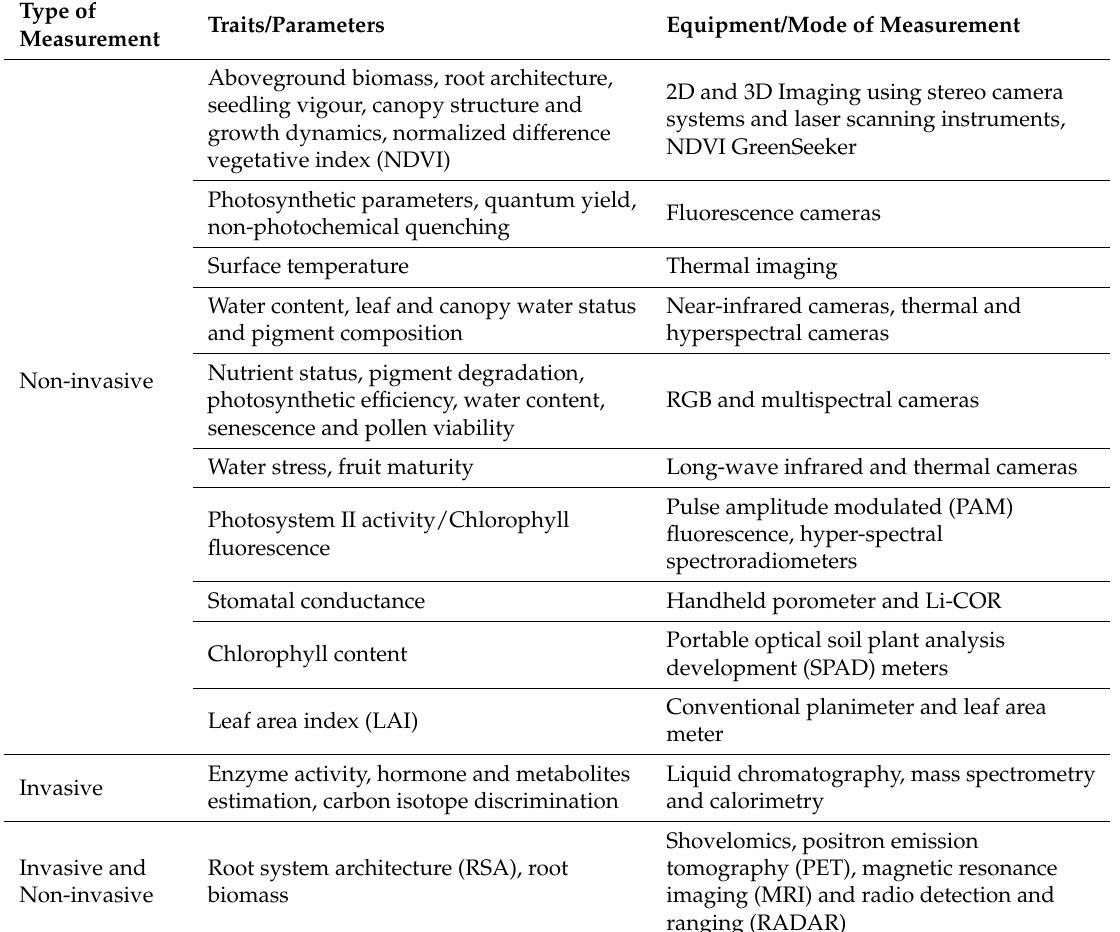
Table 1. Traits and parameters that are to be targeted in physiological breeding programs. Both non-invasive and invasive types of measurements are listed